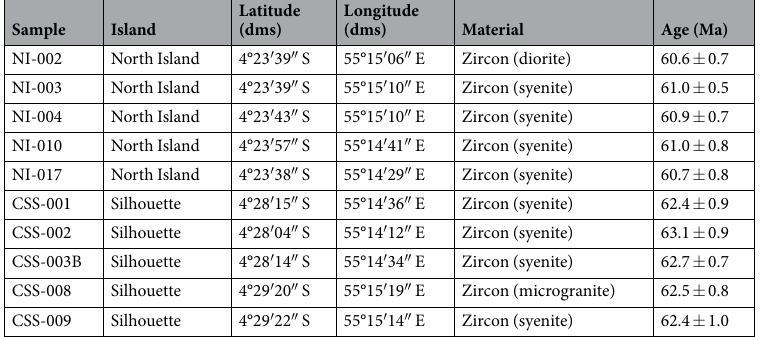
Table 1. Summary of mean zircon 206 Pb/ 238 U age dates from the Silhouette/North Island complex. The complete dataset can be found in Dataset S1. The geographic coordinates are in degrees, minutes and seconds